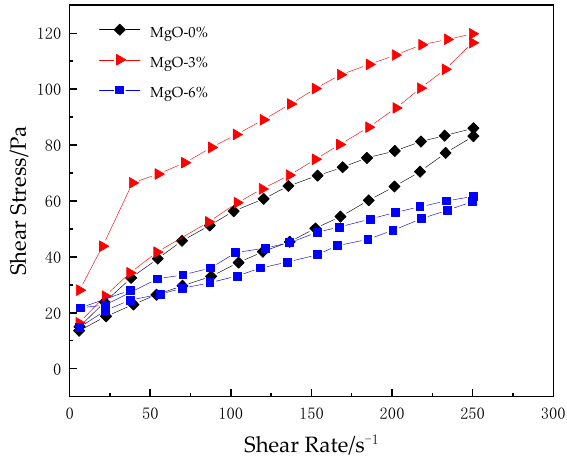
Figure 8. Thixotropic ring areas with different magnesia expansion agent contents.